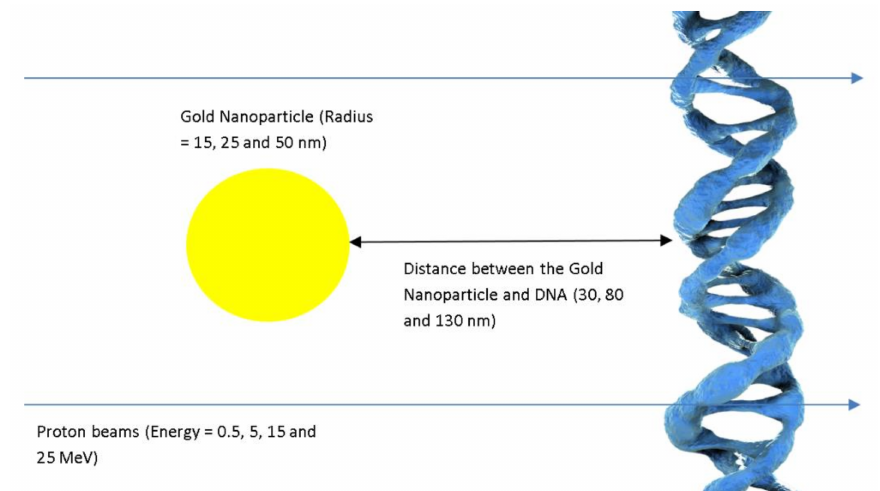
Figure 1. Schematic diagram showing the MC simulation geometry in Geant4-DNA (not to scale). The gold nanoparticle was located between the proton beam source and DNA molecule. Nanoparticle radii of 15, 25 and 50 nm were used in the simulation. The distance between the nanoparticle and DNA was equal to 30, 80 and 130 nm, and the proton beam energy was equal to 0.5, 5, 15 and 25